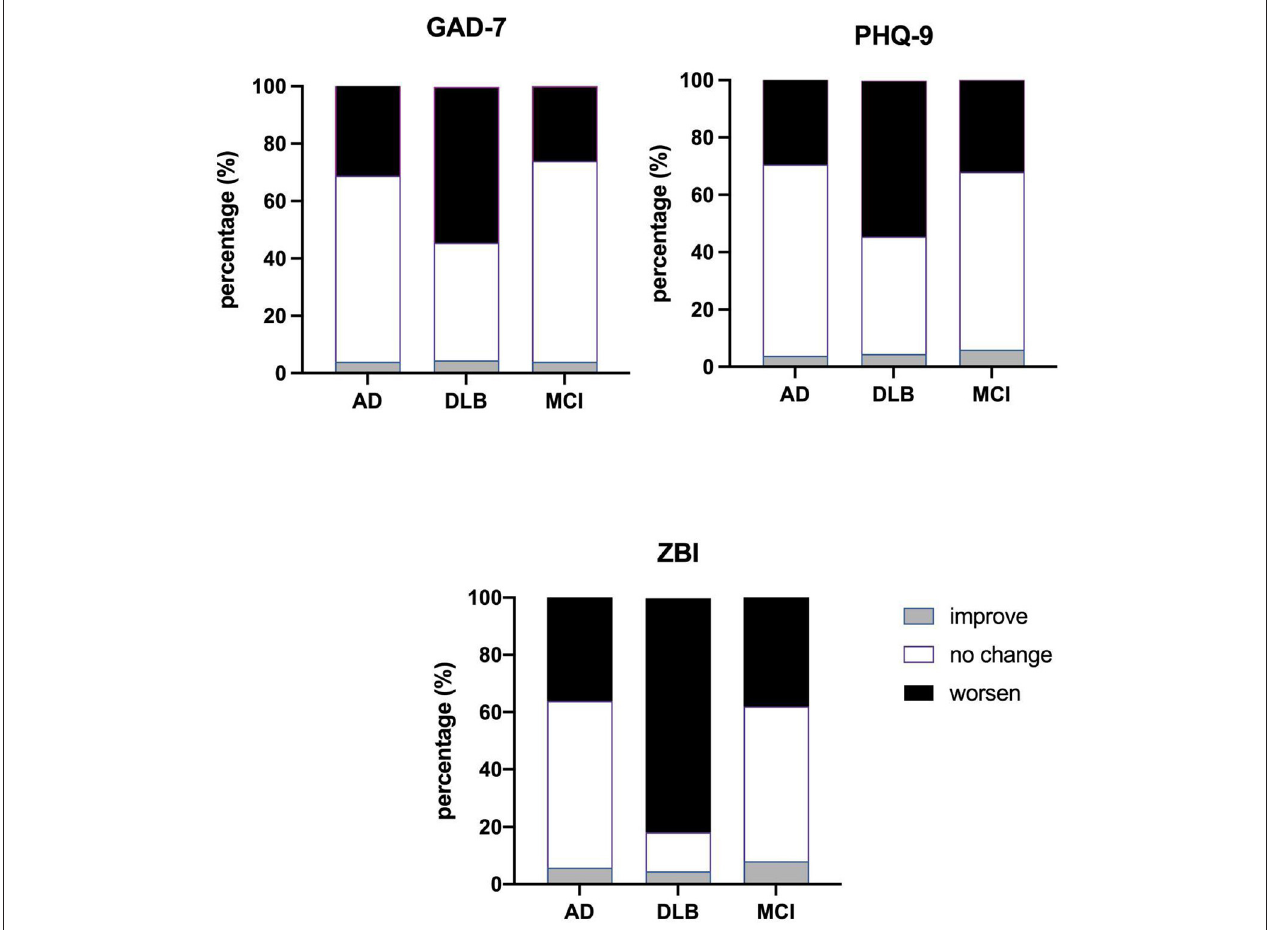
FIGURE 1 | Comparison of changes in GAD-7, PHQ-9 and ZBI in the three groups. AD, Alzheimer’s disease; DLB, Dementia with Lewy bodies; MCI, Mild Cognitive Impairment; ZBI, Zarit Burden Interview; GAD-7, Generalized Anxiety Disorder Scale; PHQ-9, Patient Health Questionnaire.